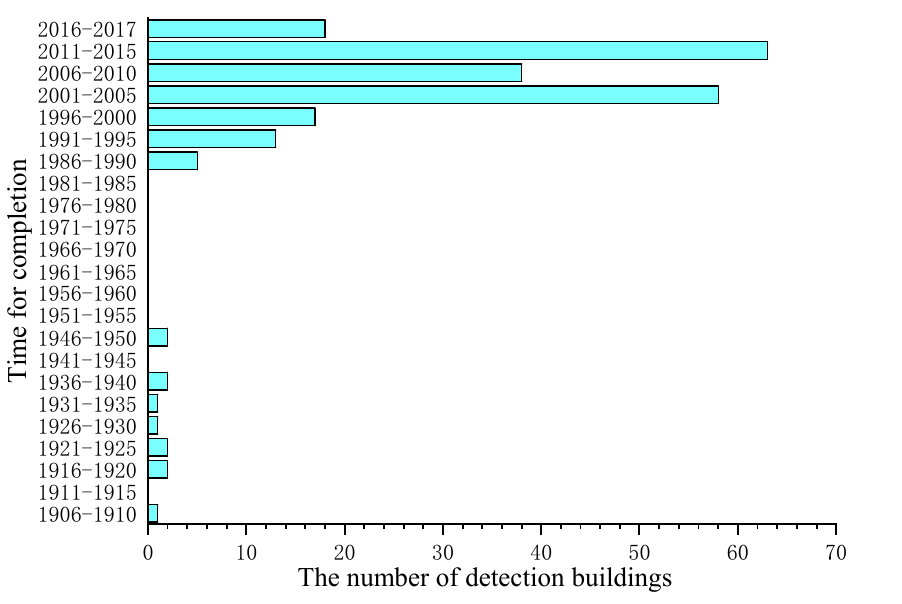
Figure 3. The completion times of detection buildings.